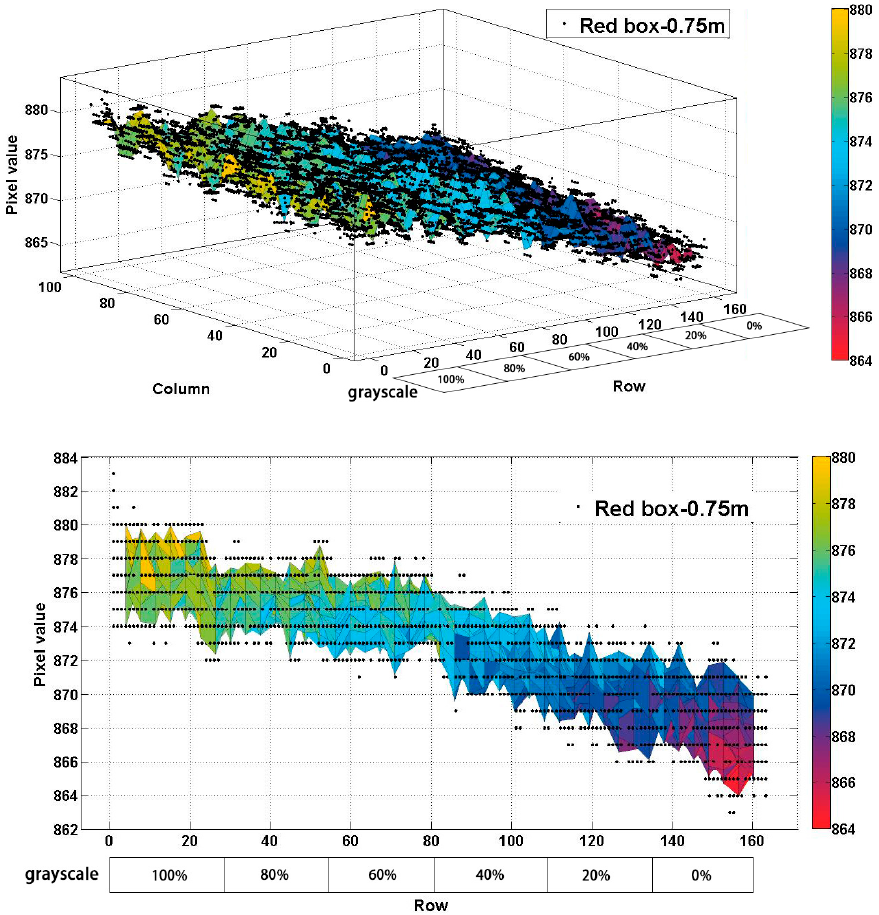
Figure 7. Red box region at distance 0.75 m: 3D view ( top ); side view ( bottom ).